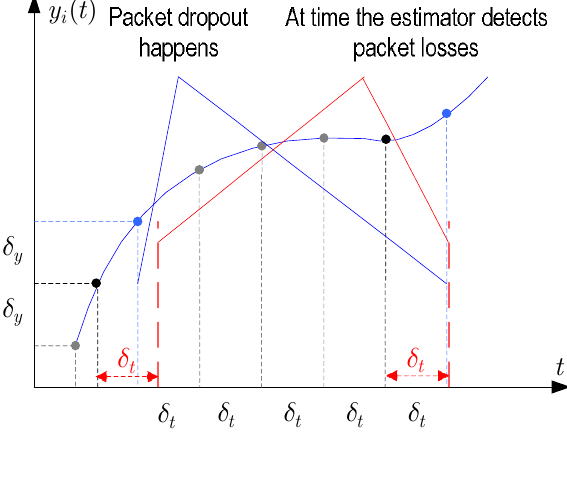
Figure 2. Multiple packet dropout